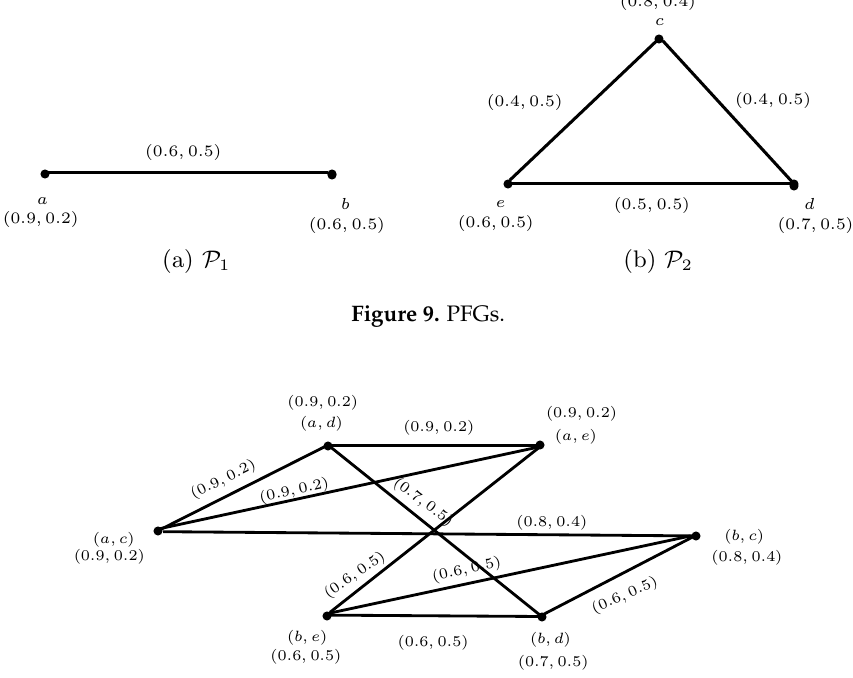
Figure 2.9: Maximal product of two PFGs. Figure 10. Maximal product of two